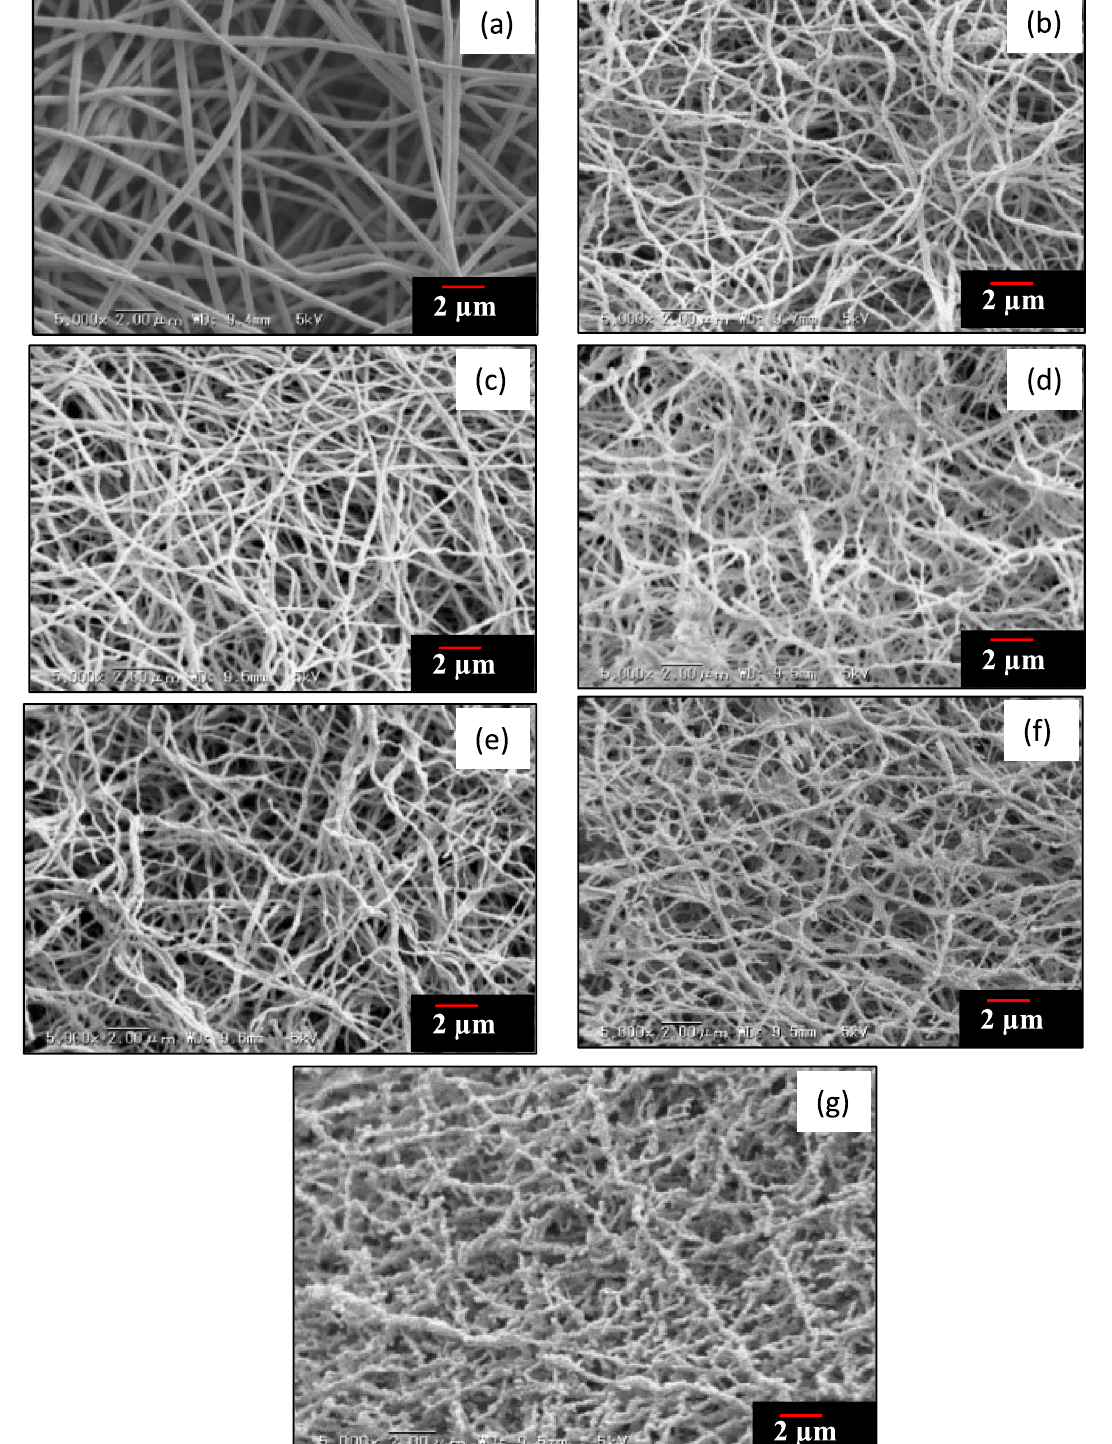
Fig. 6 SEM images of nanofibers: ( a ) PVA/BeSO and ( g ) 1200